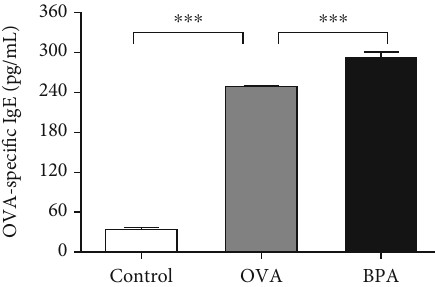
Figure 3: BPA increased the serum OVA-speci fi c IgE levels, as shown by ELISA. Data are expressed as means ± SEM ; n = 5 in each group. ∗∗∗ P < 0 : 001